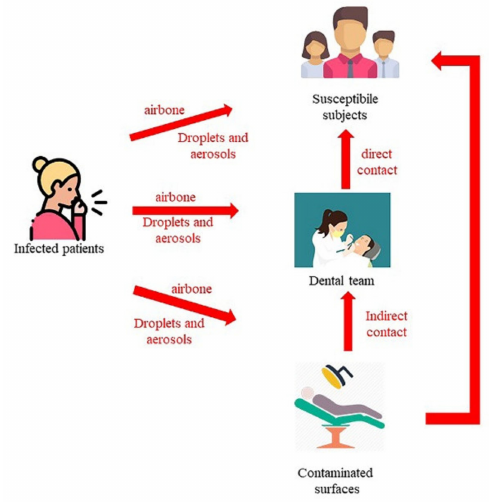
Figure 2. the three main routes of transmission for infectious